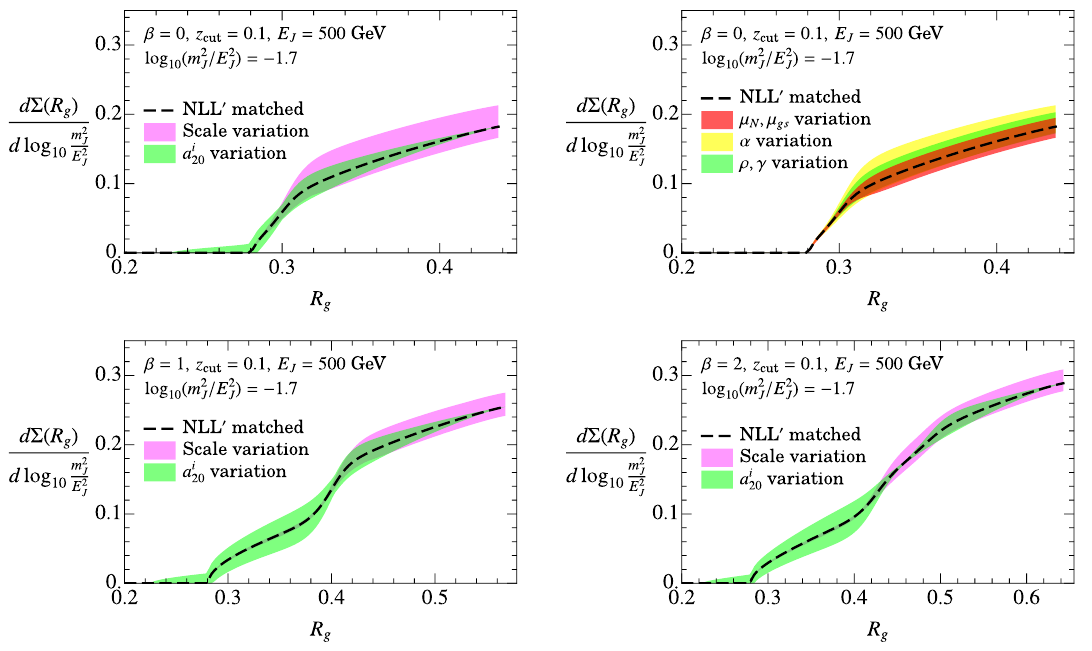
Figure 7 . Theoretical uncertainty on the cross section cumulant in R g , for log and different values of β . The central curve (black dashed) is obtained with the matching prescrip- tion described in the text, while the colored bands probe respectively scale variation (magenta), and variation of the fixed order two-loop constants a S c (green). In the top right plot, the envelope of scale variations for β = 0 is broken down into various components: overall variation by a common factor (red), variation by a trumpet factor preserving canonical relations (yellow), breaking of canonical relations